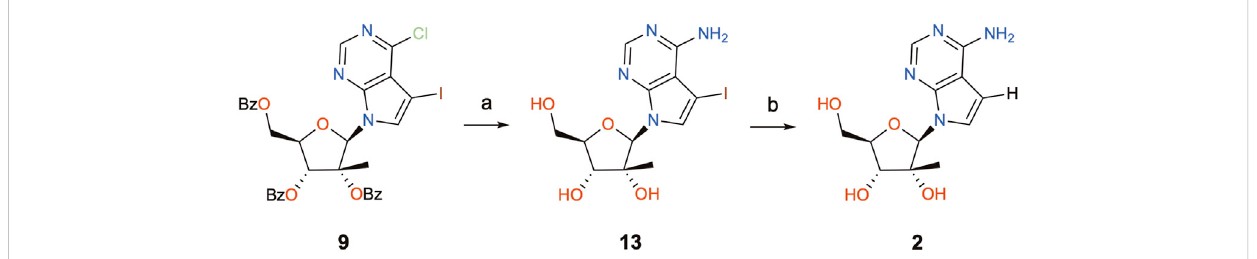
SCHEME 4 Completion of the synthesis of 7DMA. Reagents and conditions: (a) aq. NH 3 , dioxane, 120 ° C (sealed tube), 21 ° h, 42 – 98%; (b) H-Cube ® Pro reactor, 30 mm Pd/C 10% cartridge, Et